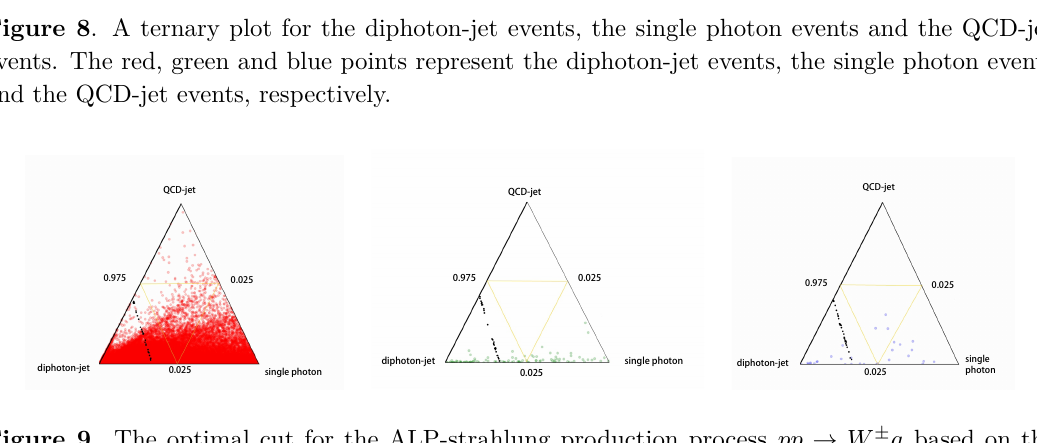
Figure 9 . The optimal cut for the ALP-strahlung production process pp → W ± a based on the selection NN with g = 0 . 64 TeV − 1 and m = 3 GeV. The red, green and blue points represent aγγ a the diphoton-jet events, the single photon events and the QCD-jet events while the black line is the optimal